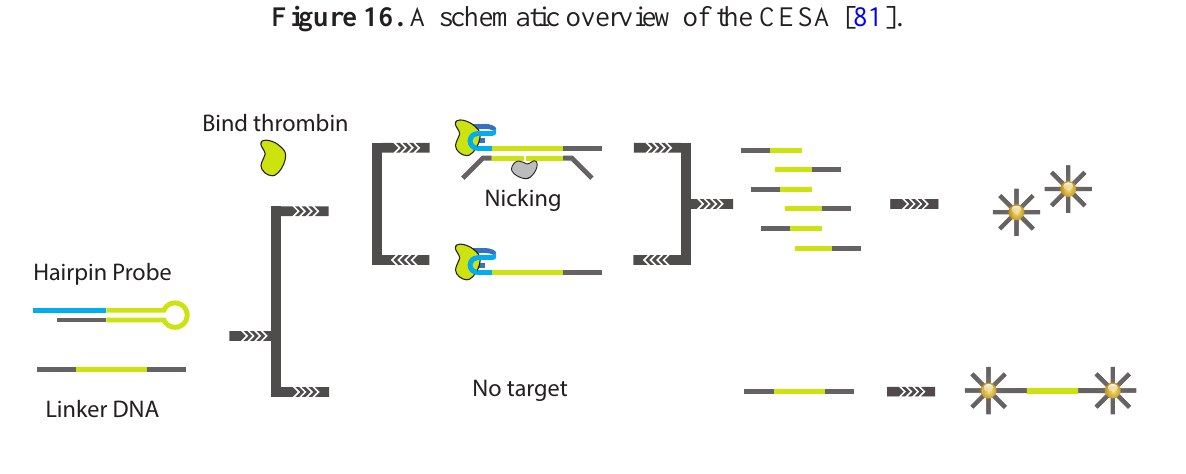
Figure 16. A schematic overview of the CESA